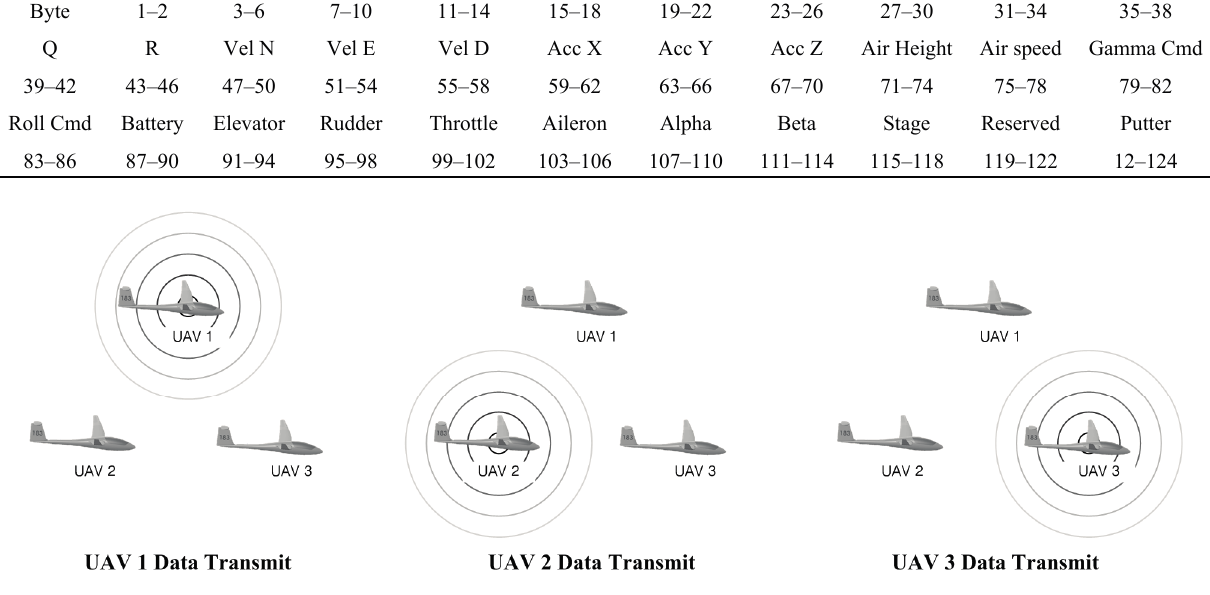
Figure 4. Description of sequential cyclic